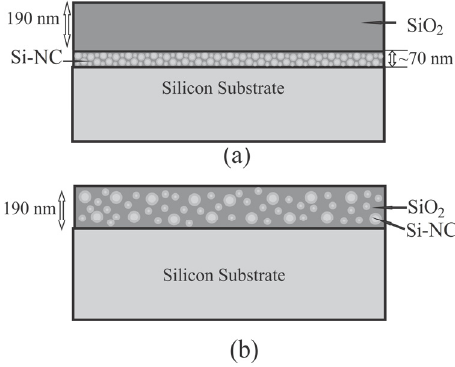
Figure 1. Schemes for: ( a ) coated; and ( b ) embedded films with red or blue Si-NCs (silicon nanocrystals).